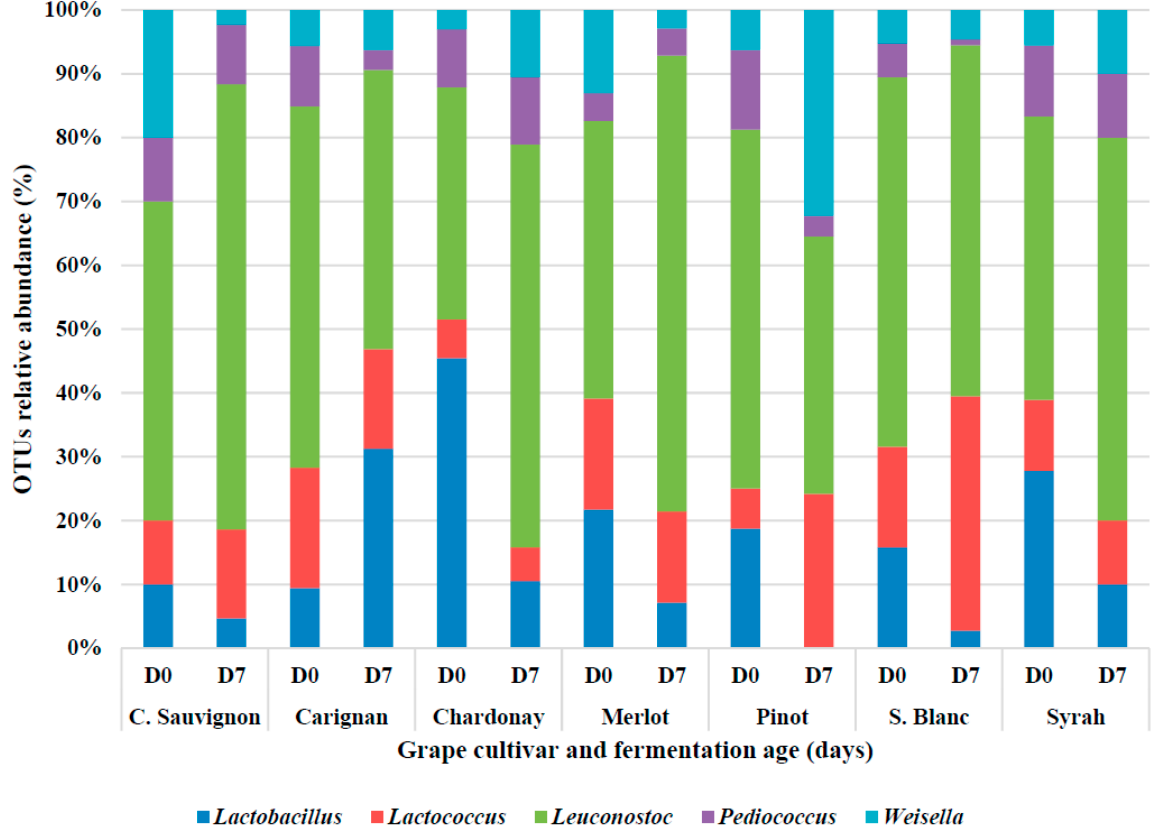
Figure 4. Results of the 16S rRNA gene amplicon sequencing data analysis for the fresh and fermented grape juices collected at days 0 and 7 of the fermentation. Data are presented by grape cultivar.